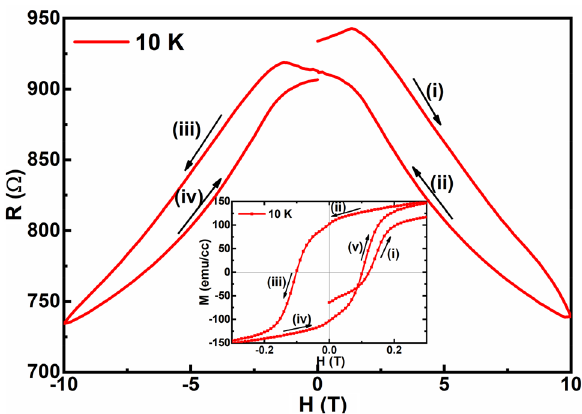
Figure 11. Training effect observed in the isothermal field-dependent resistance measurement for PSMO/ PCMO/STO. Inset shows a similar observation in the isothermal field-dependent magnetization measurements for